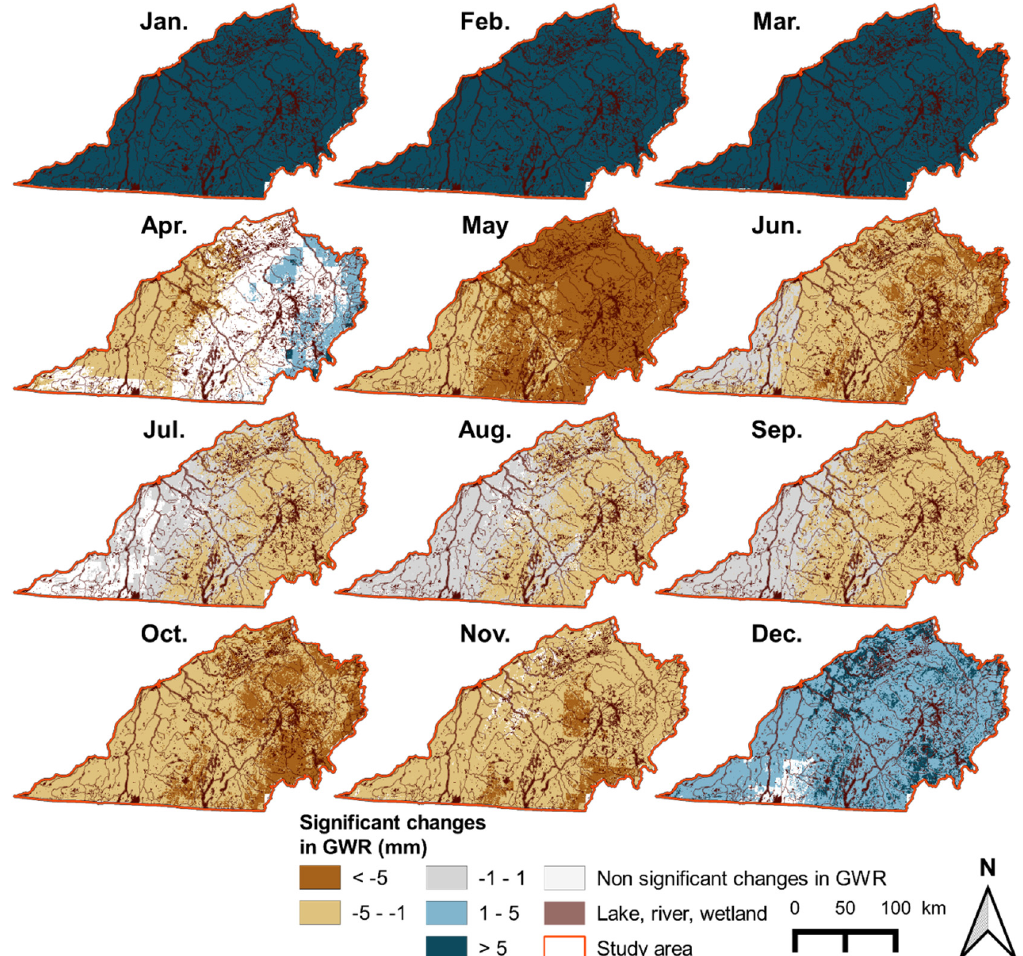
Figure 7. Spatial changes in average monthly groundwater recharge (GWR) between the reference period (1981 − 2010) and the 2071 − 2100 period for the 12 climate scenarios.